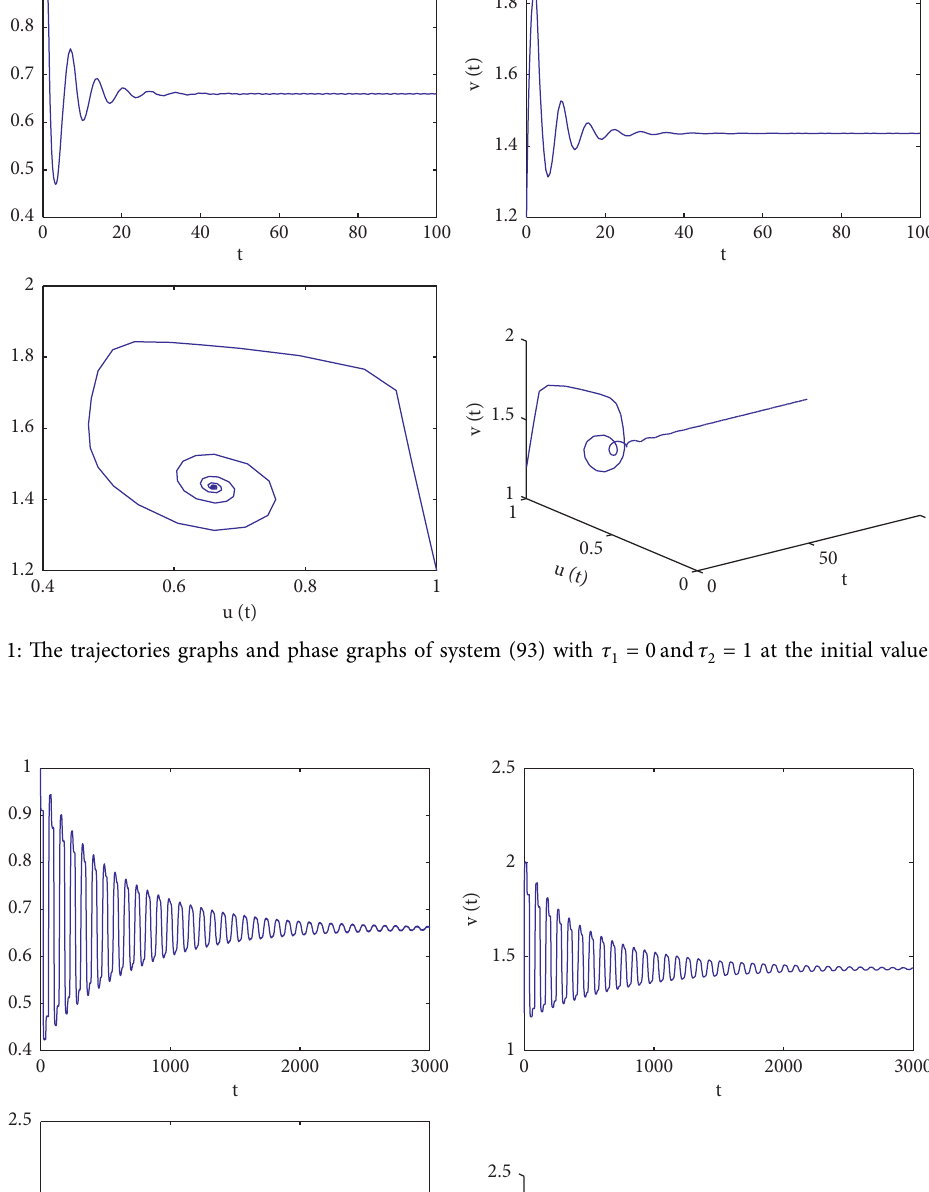
� 0 and τ � 20 at the initial value ( 1 , 1 . 2 ) 1 2